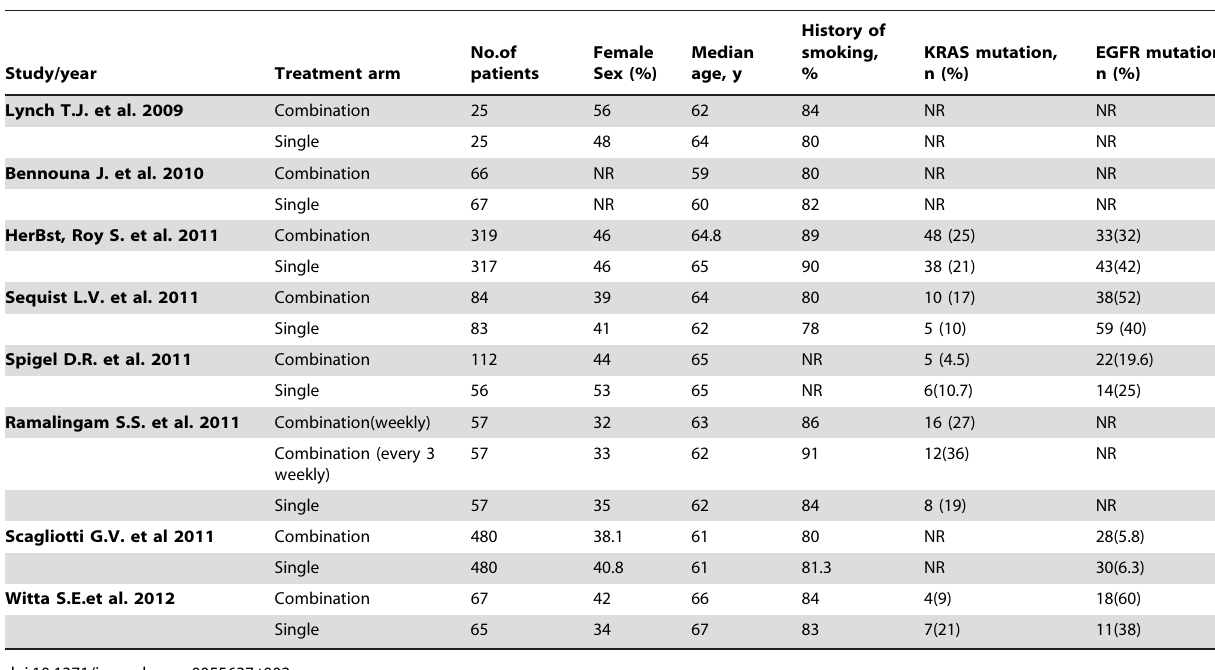
Table 2. Characteristics of patients in the pooled analysis (N=2417).